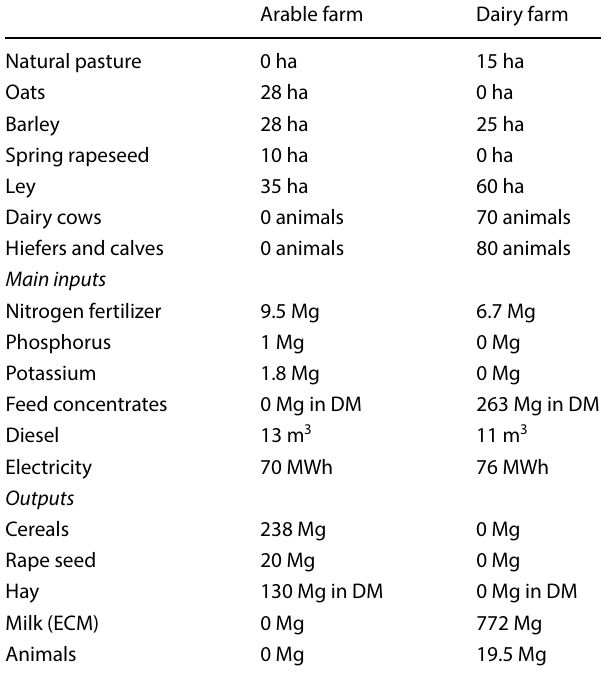
Table 1 Characteristics of the two case farms in Sweden Arable farm Dairy